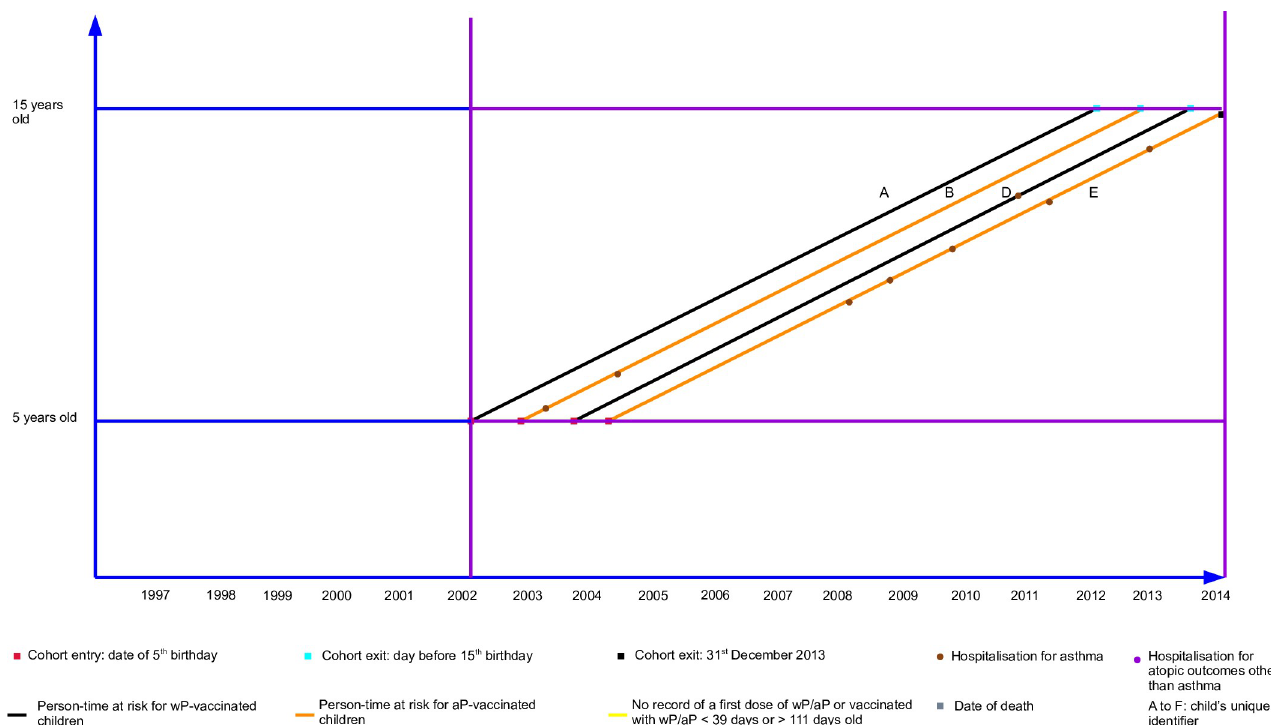
Fig 2. Lexis diagram (after data cleaning). Legend: Person-time-at-risk experience of children born in WA or NSW between 1 January 1997 and 31 December 1999 after data cleaning.